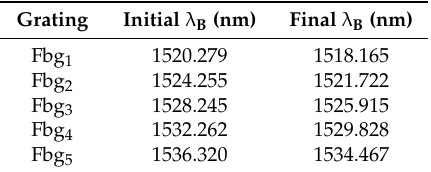
Table 1. FBG central wavelengths λ B before and after production for the A380 hinge arm.